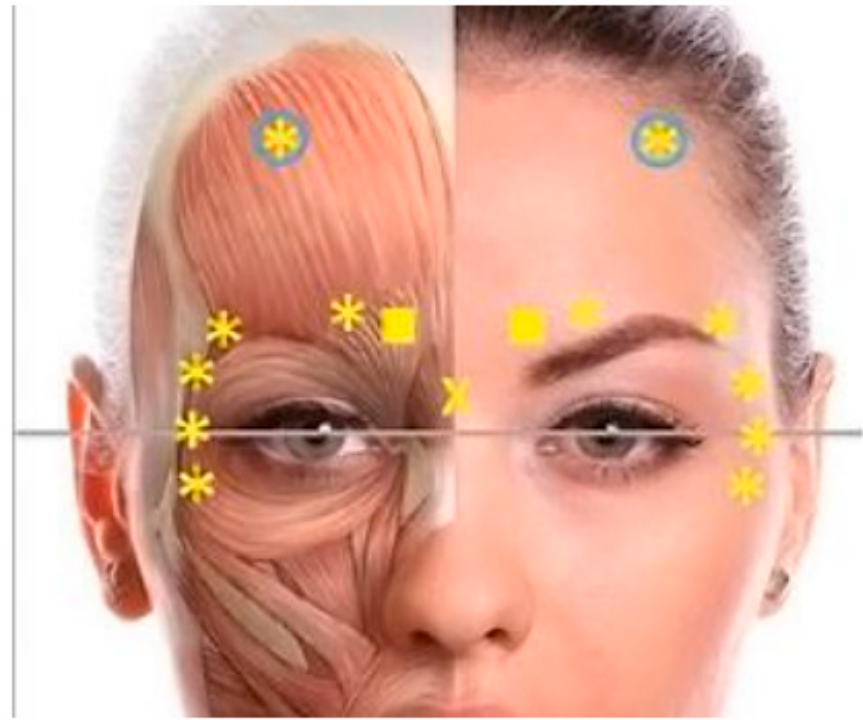
Figure 12. Five glabellar complex sites; eight crow’s feet line sites are injected (four on each side). Note that the various symbols used here represent different injection depths: squares indicate full-needle depth, Xs indicate one-half needle depth, and asterisks indicate one-third needle depth [55].